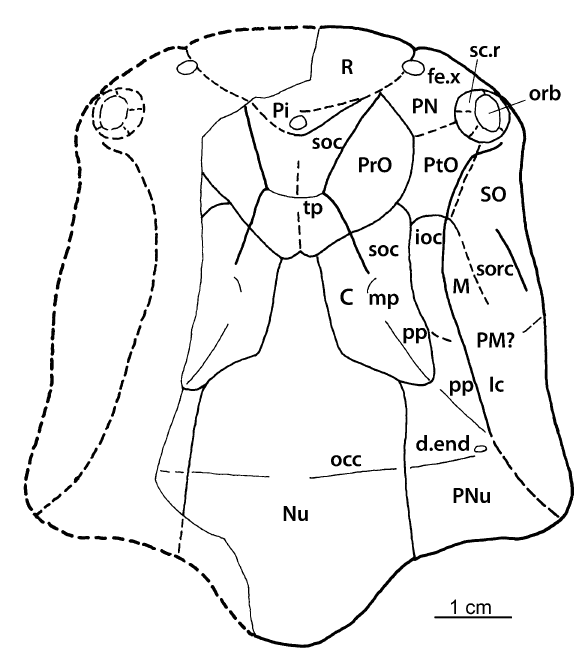
Fig. 3. Eukaia elongata gen. et sp. nov. Attempted restoration of the dermal plate pattern in the skull roof. Abbreviations: C, central plate; d.end, foramen of endolymphatic duct; fe.x, excurrent nasal opening; ioc, infraorbital sensory line; lc, main lateral line; M, marginal plate; mp, middle pit-line; Nu, nuchal plate; occ, occipital cross commissure; orb, orbital opening; Pi, pineal plate; PM?, postmarginal? plate; PN, post- nasal plate; PNu, paranuchal plate; pp, posterior pit-line; PrO, preorbital plate; PtO, postorbital plate; R, rostral plate; sc.r, sclerotic ring; SO, suborbital plate; soc, supraorbital sensory line; sorc, supraoral sensory line; tp, transverse pit-line.